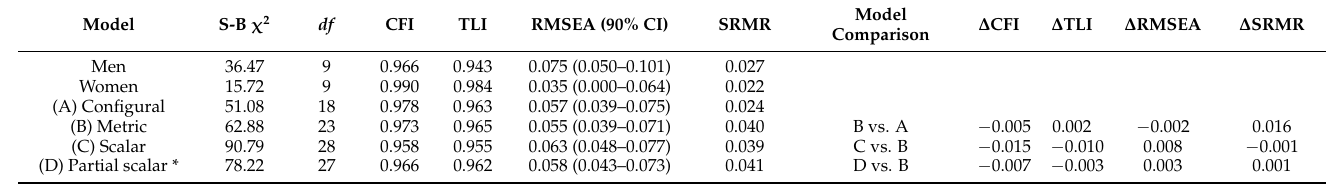
Table 3. Goodness-of-fit indices and model comparisons for measurement invariance models.